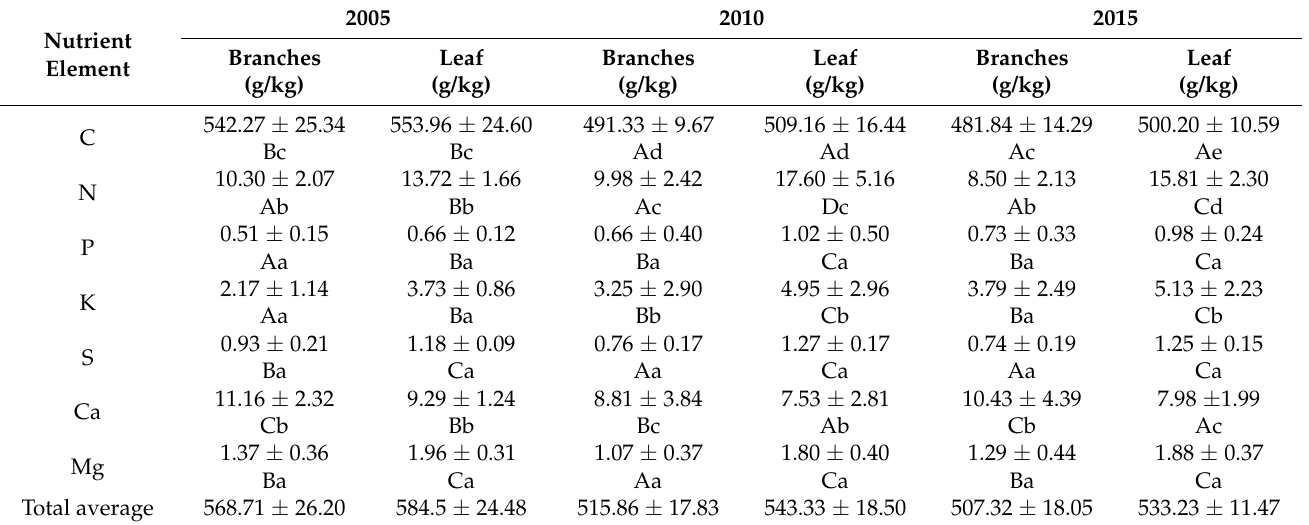
Table 6. Characteristics of annual average nutrient return of litterfall in different